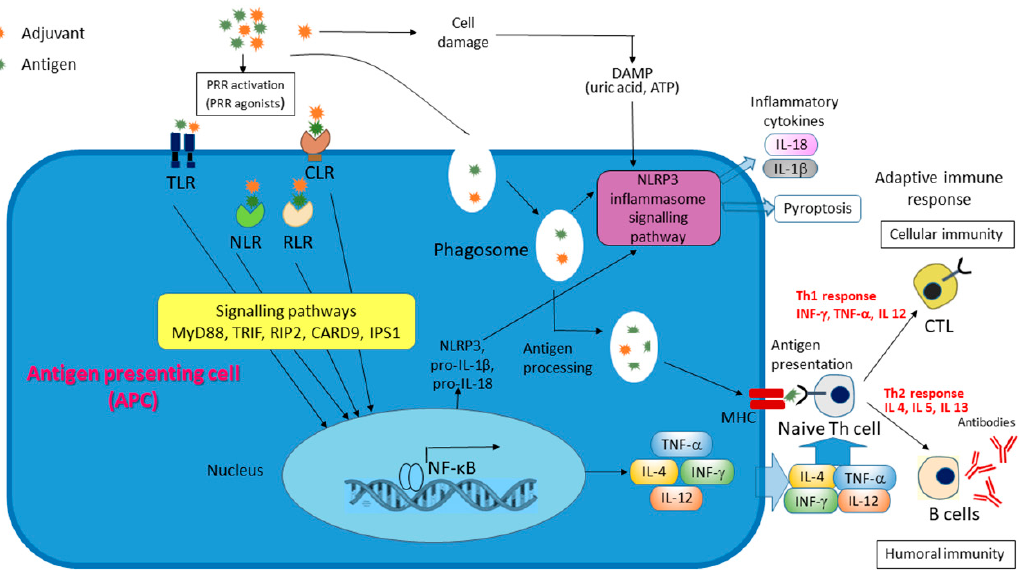
Figure 4. Putative mechanisms of action of the proposed adjuvants. Pattern recognition receptors (PRRs) allow innate immunity cells to recognize pathogen-associated molecular patterns (PAMPs) of microbes or damage-associated molecular patterns (DAMPs), which are released from injured or dying cells. The PRRs includes Toll-like receptors (TLRs), Nod-like receptors (NLRs), and и C-type lectin receptors (CLRs), which are considered receptors of adjuvants. NLRP3—NLR pyrin domain-containing protein 3.